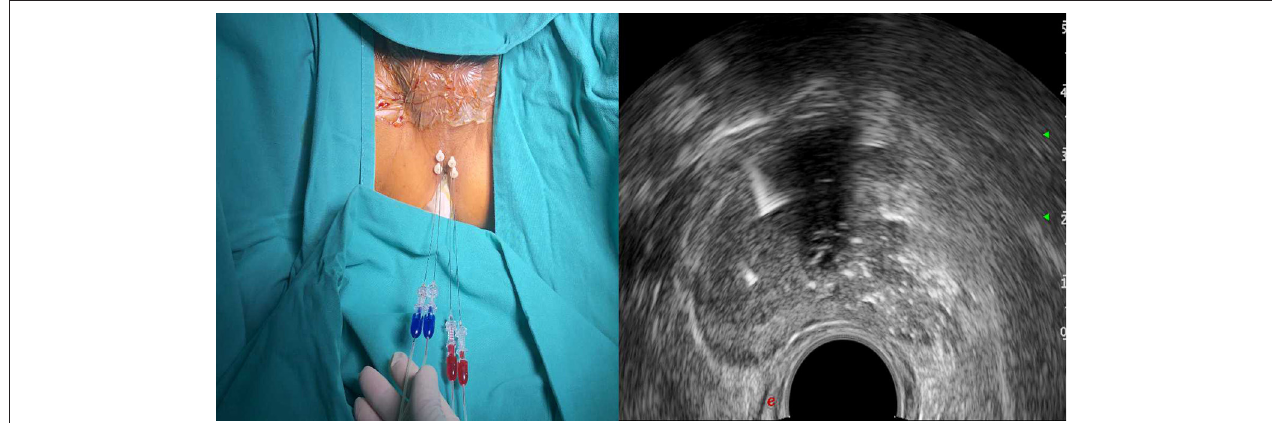
FIGURE 4 | Planning of the procedure. Four fibres for a prostate volume larger than 40ml (two for each side).